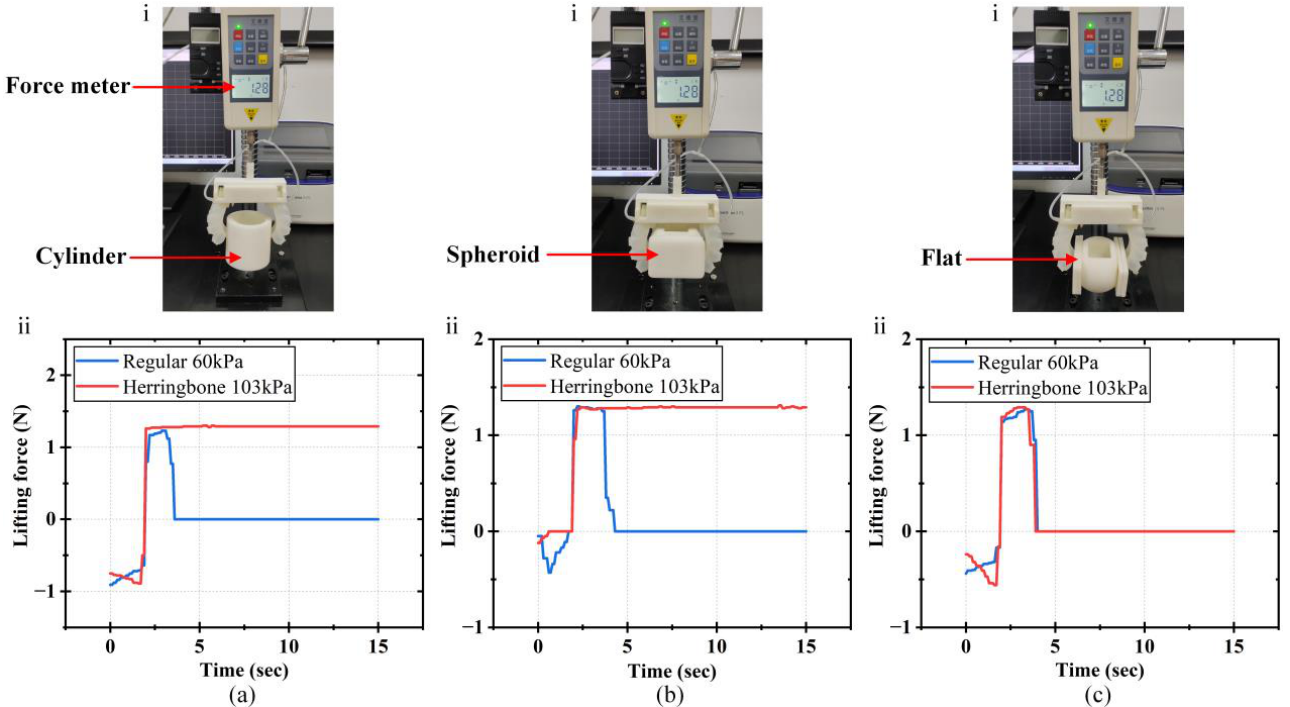
Figure 6. Lifting force test of the soft gripper. The soft gripper lifts ( a ) a cylindrical part, ( b ) a spheroid, and ( c ) a flat. Figures ( i ) show the snapshots of the lifting experiments, and Figures ( ii ) show the measured lifting forces of the different objects.